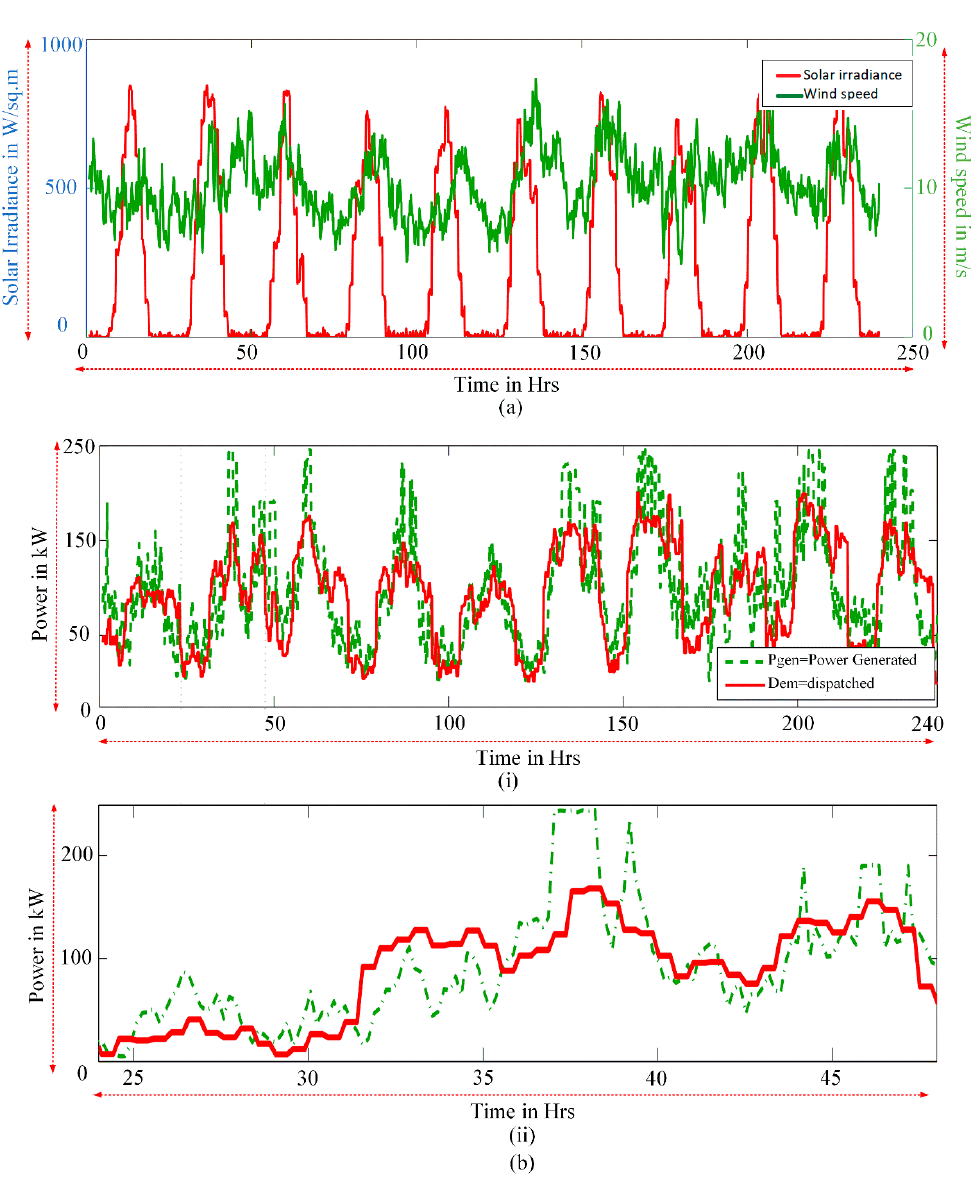
Figure 5. ( a ) Wind speed and Solar irradiance ( b ) Forecasted Hybrid Renewable Energy System (HRES) power vs Actual HRES power generated (i) 10 days; (ii) for 24 h simulation period.